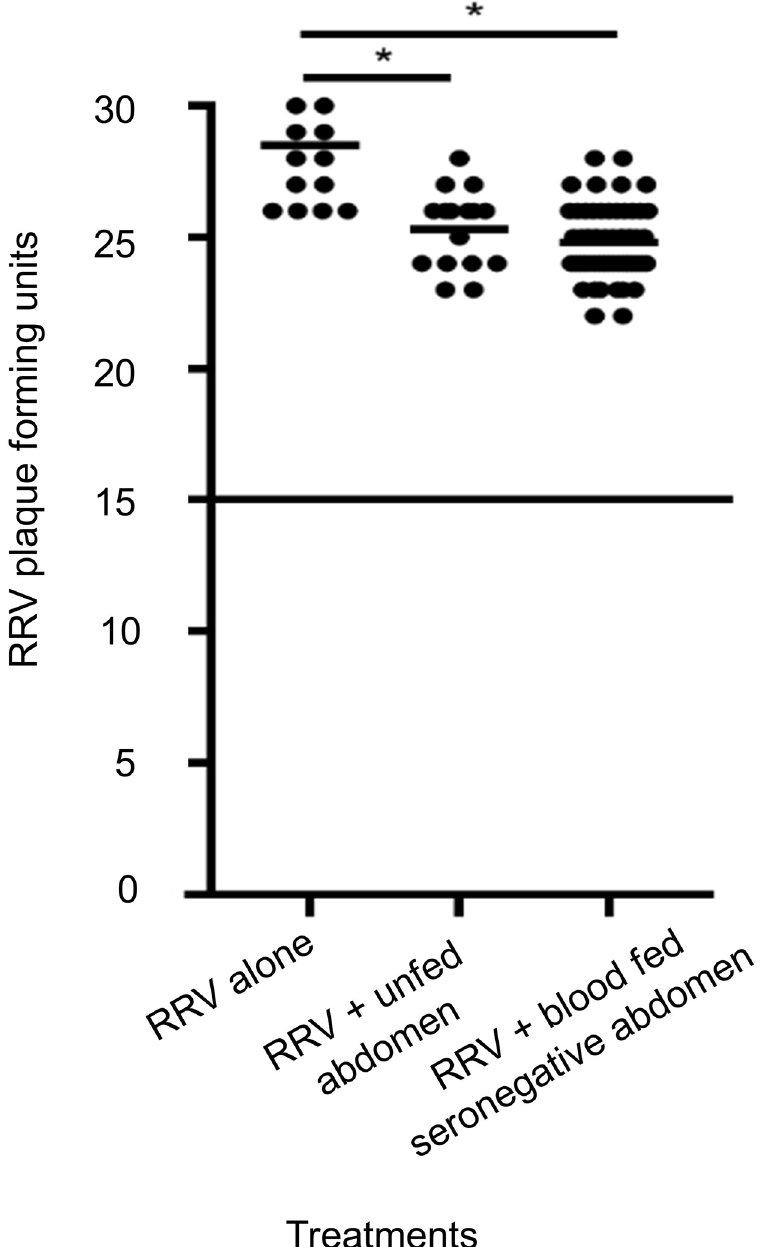
Fig 3. The effect of mosquito homogenates on plaque formation. Homogenates of mosquito abdomens reduce the number of plaque forming units by approximately 10%, when compared with Vero cells inoculated with RRV alone ( � p < 0.05, calculated by one-way ANOVA